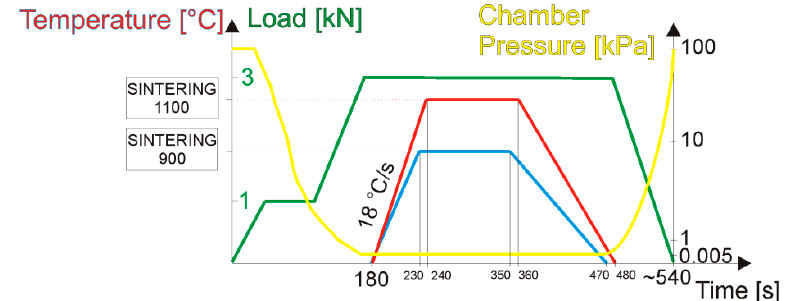
Figure 2. The Pulse Plasma Sintering processing parameter setup using the ‘save/ load’ operational function, presented in the form of a graph.